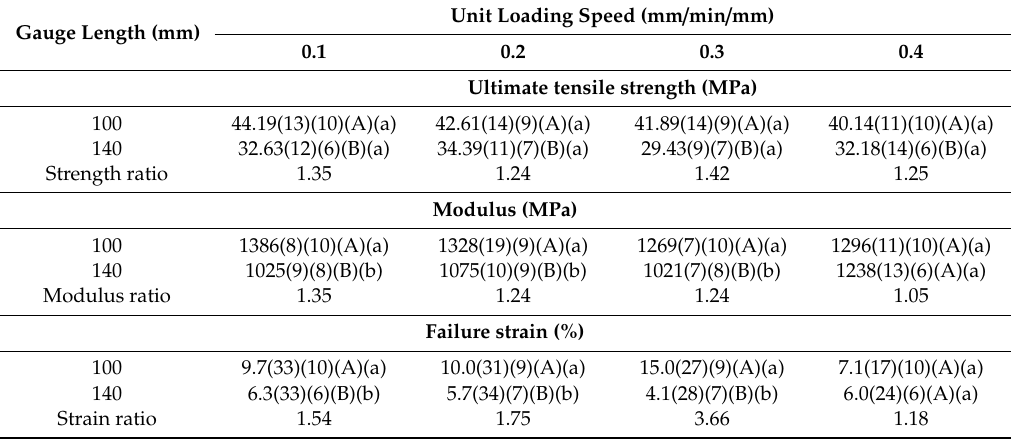
Table 6. Mean values of ultimate tensile strength, tensile modulus, and failure strain of rattan bast strips evaluated in test 2 for each combination of unit speed and gauge length and their corresponding mean comparisons for unit loading speed and gauge length 1